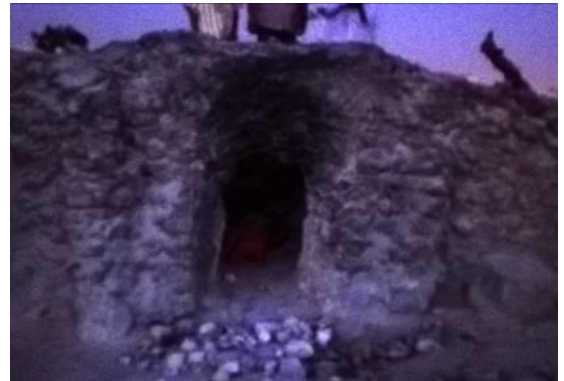
Figure 4. Traditional Furnace of Gypsum.